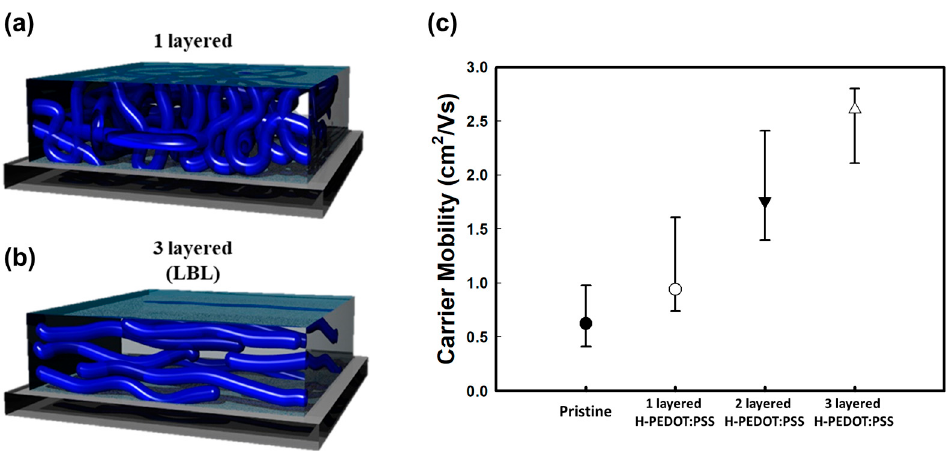
Figure 6. The post-treated H-PEDOT:PSS thin films with ( a ) one-layered and ( b ) three-layered structures. ( c ) Carrier mobility of PEDOT:PSS thin films at room temperature.